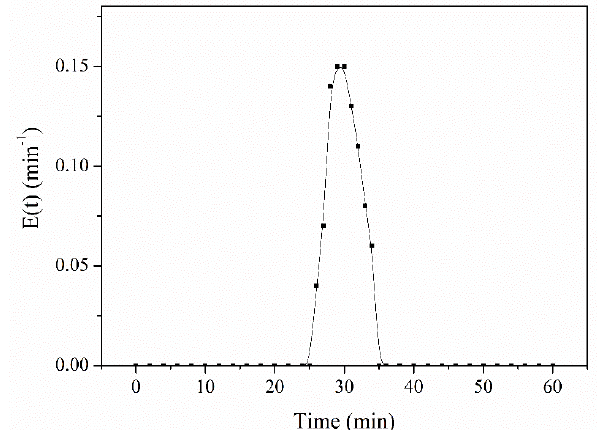
Figure 7. Residence time distribution in the Pickering-emulsion-based packed-bed microreactor.